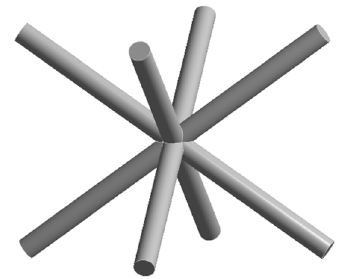
Figure 6. Schematic diagram of the body-centered cubic cell.